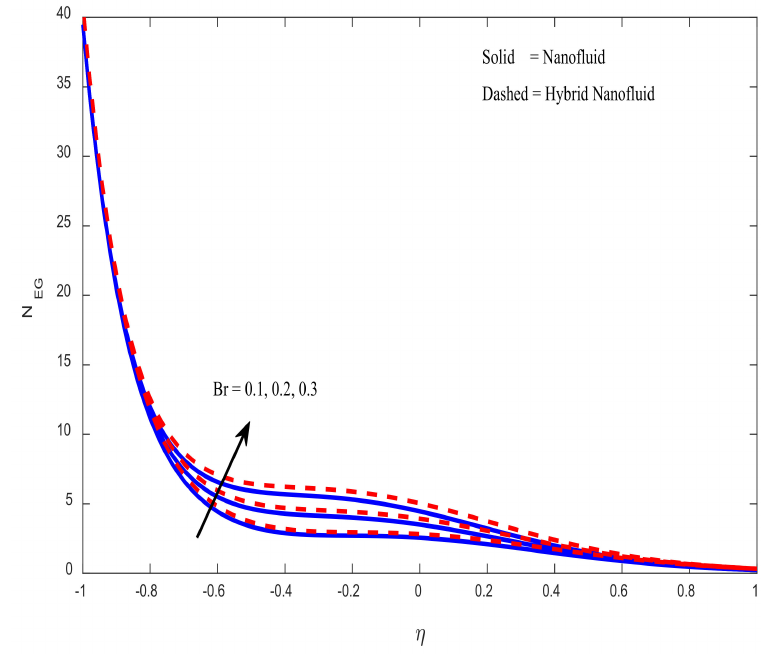
Figure 17. Influence of Br n entropy generation